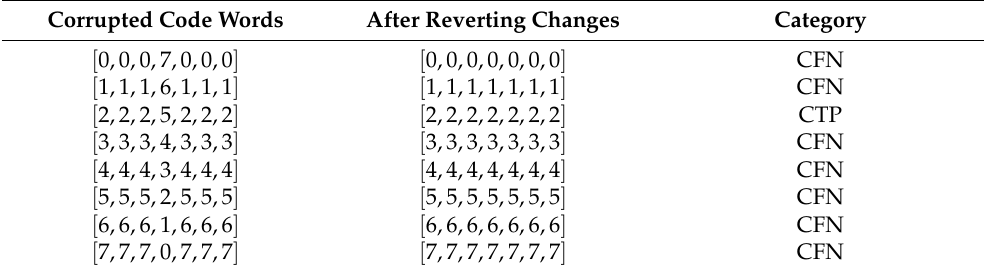
Table 4. Possible code words that can turn into one-symbol-value code words at the consumer side. Corrupted Code